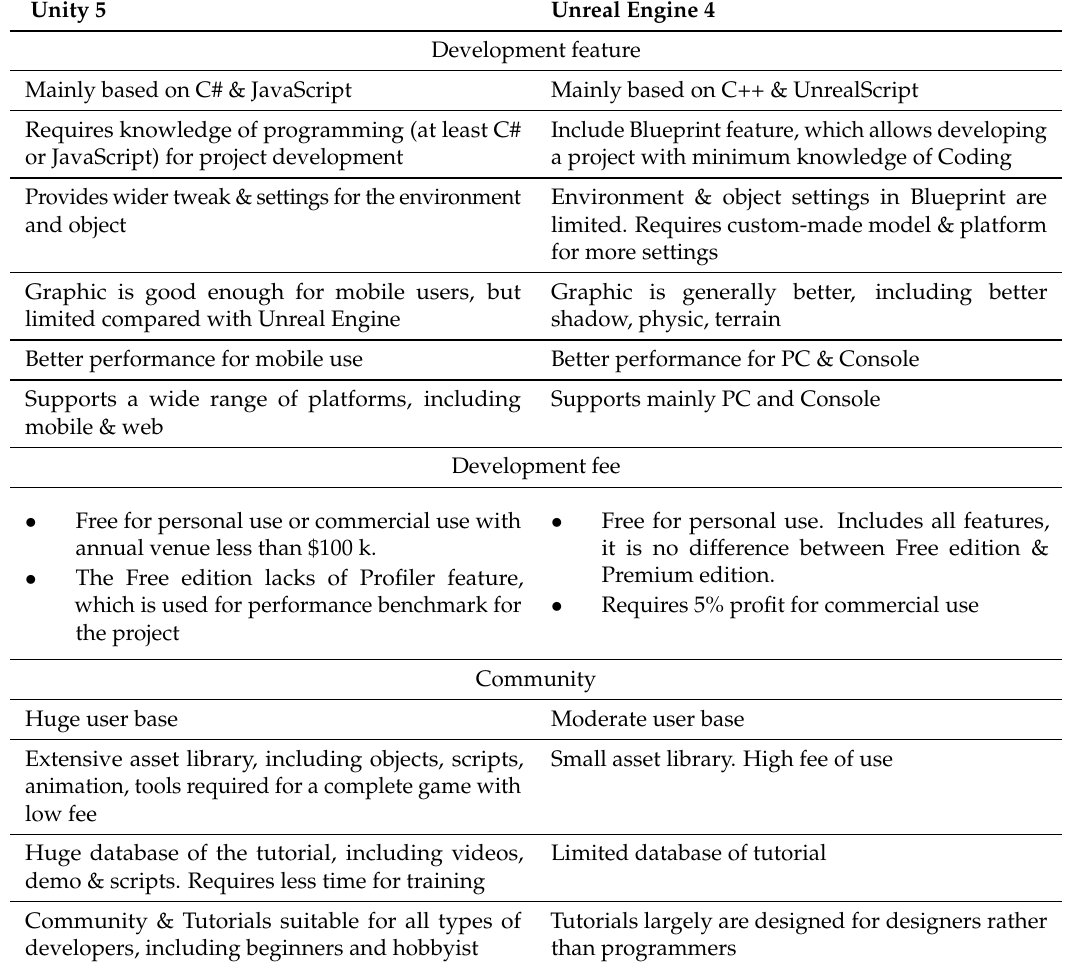
Table 1. VR IDE comparison table. Acquired from